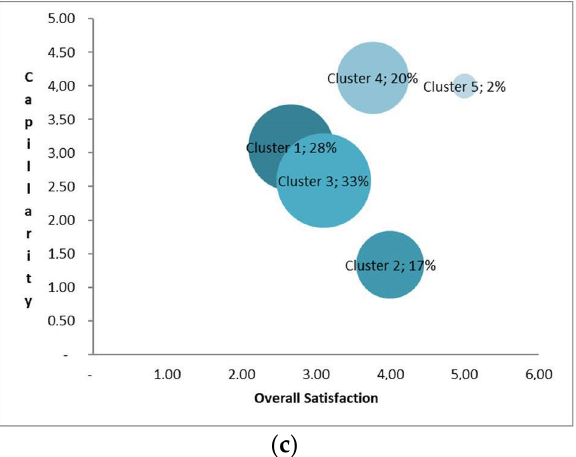
Figure 3. ( a ) Sensitivity of residents to comfort. ( b ) Sensitivity of residents to price. ( c ) Sensitivity of residents to capillarity.